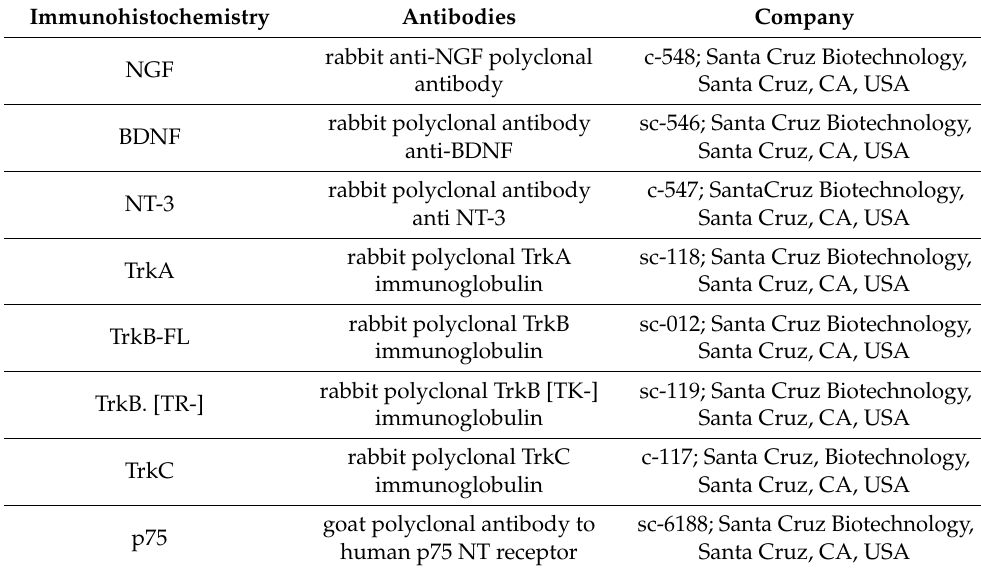
Table 3. Antibodies often used for immunohistochemistry assays